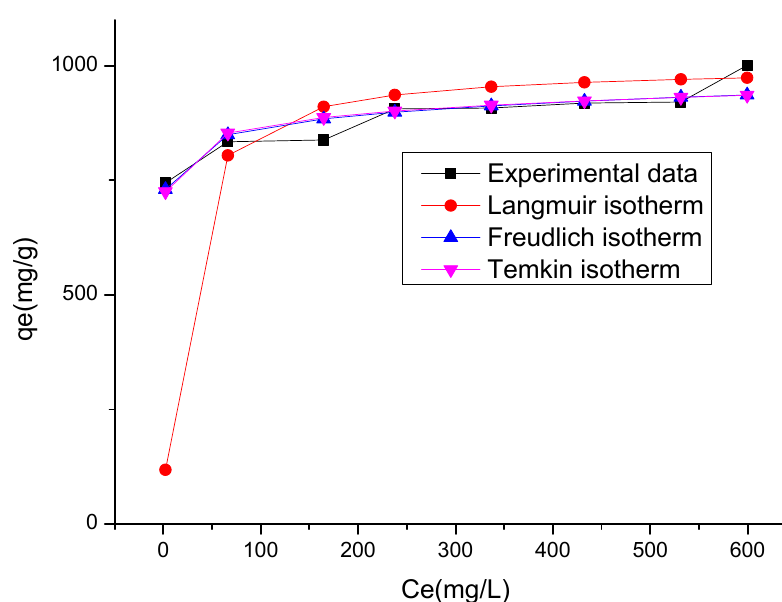
Figure 25. Adsorption isotherm of EV by Mn-doped Fe / rGO (sonication time = 23 min; initial pH = 5.0; dosage = 20 mg). Table 7. Freundlich, Langmuir and Temkin isotherm parameters for the removal of EV by Mn-doped Fe / rGO. Value of Parameters Isotherms Models Parameters